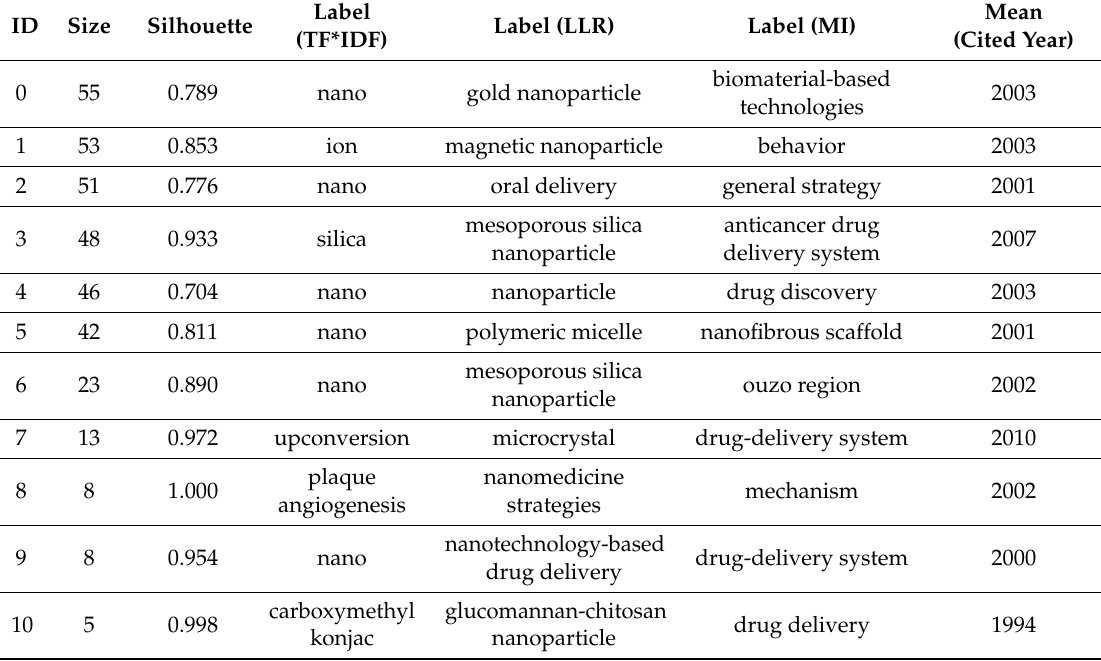
Table 2 details the top 11 clusters in rank order. Table 2. Top-ranked clusters in nanoparticle drug delivery